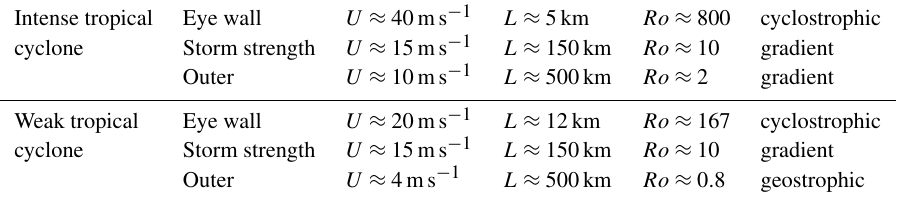
Table 1. The typical values of characteristic velocity ( U ) and characteristic length ( L ), the Rossby-number ( Ro ), and the type of the force balance in the three regions of an intense and a weak tropical cyclone. Based on MetEd (Laing and Evans, 2016). Intense tropical Eye wall U ≈ 40ms − 1 L ≈ 5km Ro ≈ 800 cyclostrophic cyclone Storm strength U ≈ 15ms − 1 L ≈ 150km Ro ≈ 10 gradient Outer U ≈ 10ms − 1 L ≈ 500km Ro ≈ 2 gradient Weak tropical Eye wall U ≈ 20ms − 1 L ≈ 12km Ro ≈ 167 cyclostrophic cyclone Storm strength U ≈ 15ms − 1 L ≈ 150km Ro ≈ 10 gradient Outer U ≈ 4ms − 1 L ≈ 500km Ro ≈ 0 . 8